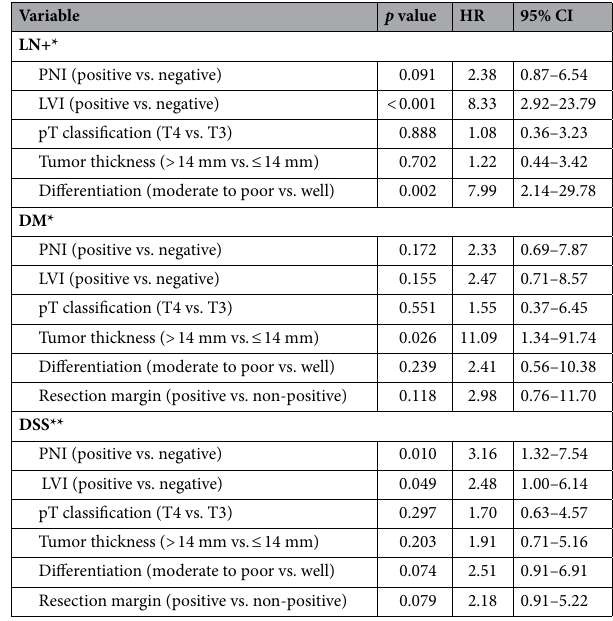
Table 2. Multivariate analyses of independent predictors of primary OSCC for LN+, DM and DSS (PNI and LVI separated). OSCC oral squamous cell carcinoma, PNI perineural invasion, LVI lymphovascular invasion, LN + neck metastasis, DM distant metastasis, DSS disease-specific survival. *Binary logistic regression. **Cox proportional hazards